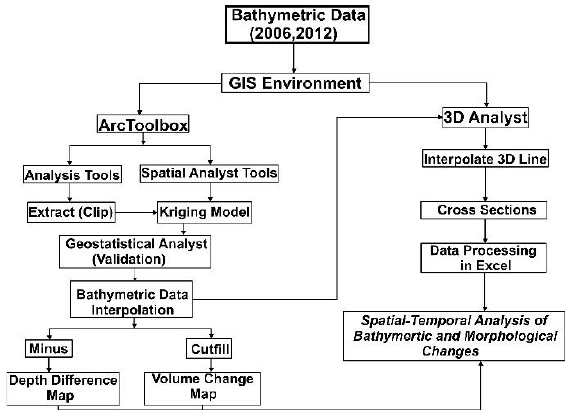
Figure 3. Flowchart of the morphosedimentary study of Oualidia lagoon .